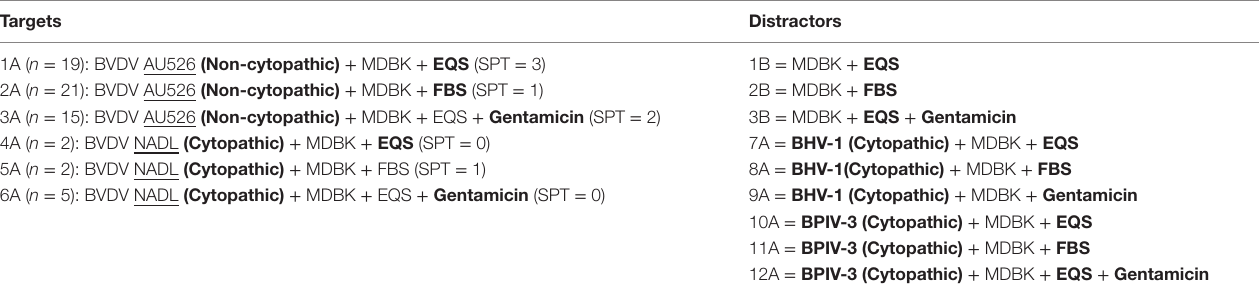
TaBle 1 | Target viruses (BVDV aU526 and BVDV naDl) and distractor viruses (BhV 1 and BPi 3) were propagated on Madin–Darby bovine kidney (MDBK) cells using one of three